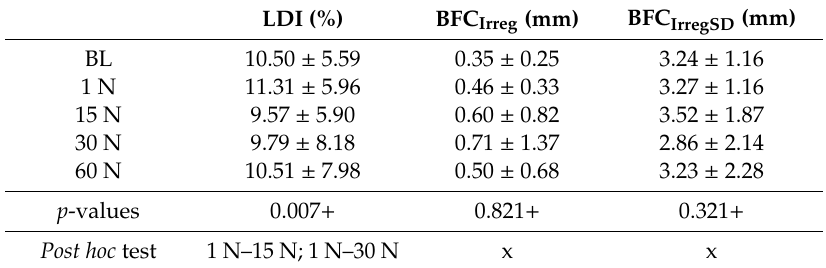
Table 2. Light disturbance index (LDI) (%; mean ± SD), irregularity of the disturbance or BFCIrreg and the SD of BFCIrreg (mm; mean ± SD) at BL and after 1, 15, 30, and 60 nights of OK lens wear. LDI (%)